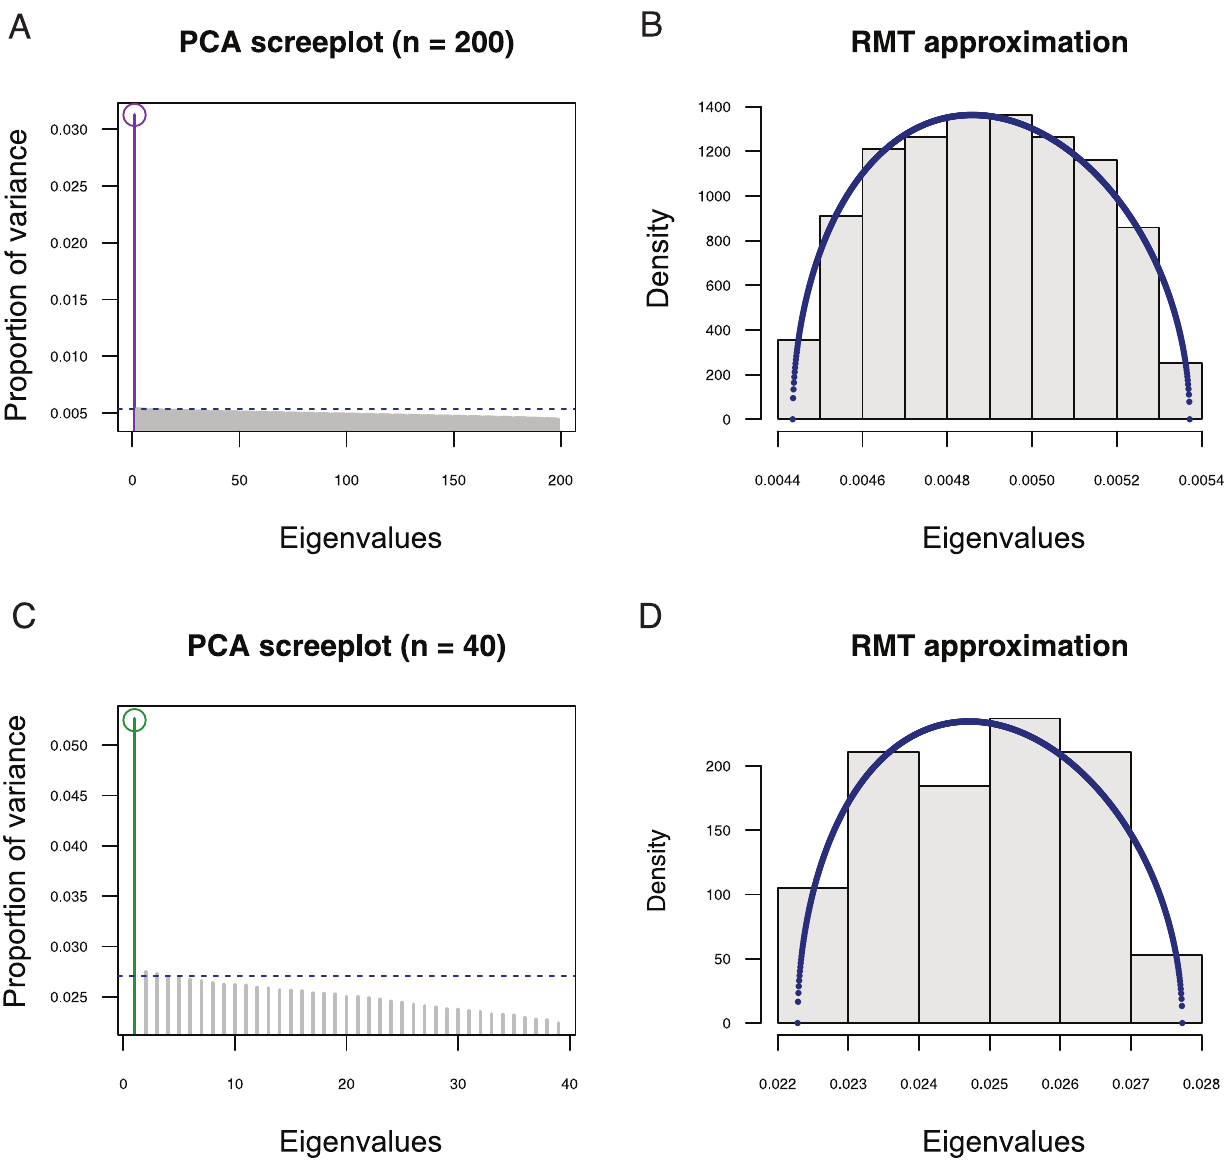
Fig 4. Scree plots and RMT approximations in two-population models. ( A ) Proportion of variance (eigenvalues) explained by PC axes, with a circle symbol representing the mean of F ST across loci for n = 200 individuals and L = 85, 540 SNPs. ( B ) Histogram of eigenvalues of the residual matrix, ffiffiffiffiffiffiffiffiffiffiffi p = , for the data simulated in A. ( C ) Proportion of variance for n = 40 individuals and L = 12, 650 SNPs. ( D ) Histogram of eigenvalues of the Z n (cid:0) 2 S residual matrix for the data simulated in C. The dashed lines in PCA scree-plots represent the RMT approximation of the leading eigenvalue of the residual matrix. The blue curve represents the Marchenko-Pastur probability density. Simulations of F -models were performed with p anc drawn from a beta(1,9) distribution and F 1 = F 2 =